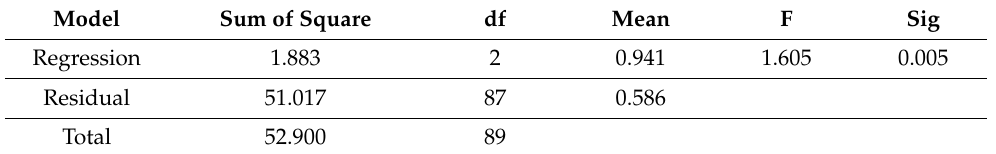
Table 11. Inferential Analysis (Regression).